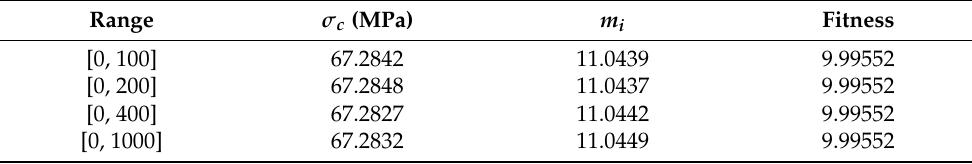
Table 2. The parameters of the failure criterion and fitness value in different ranges.